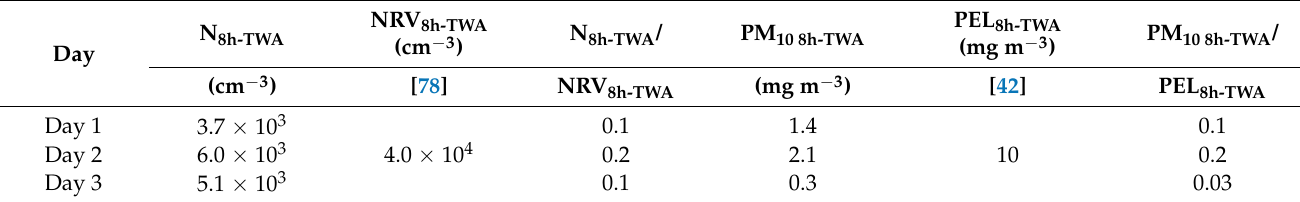
Table 3. Background corrected 8 h-TWA particle number ( N ) and PM 10 exposure concentrations obtained for each working day, and comparison with the nano-reference value (NRV) and the permissible exposure limit (PEL).